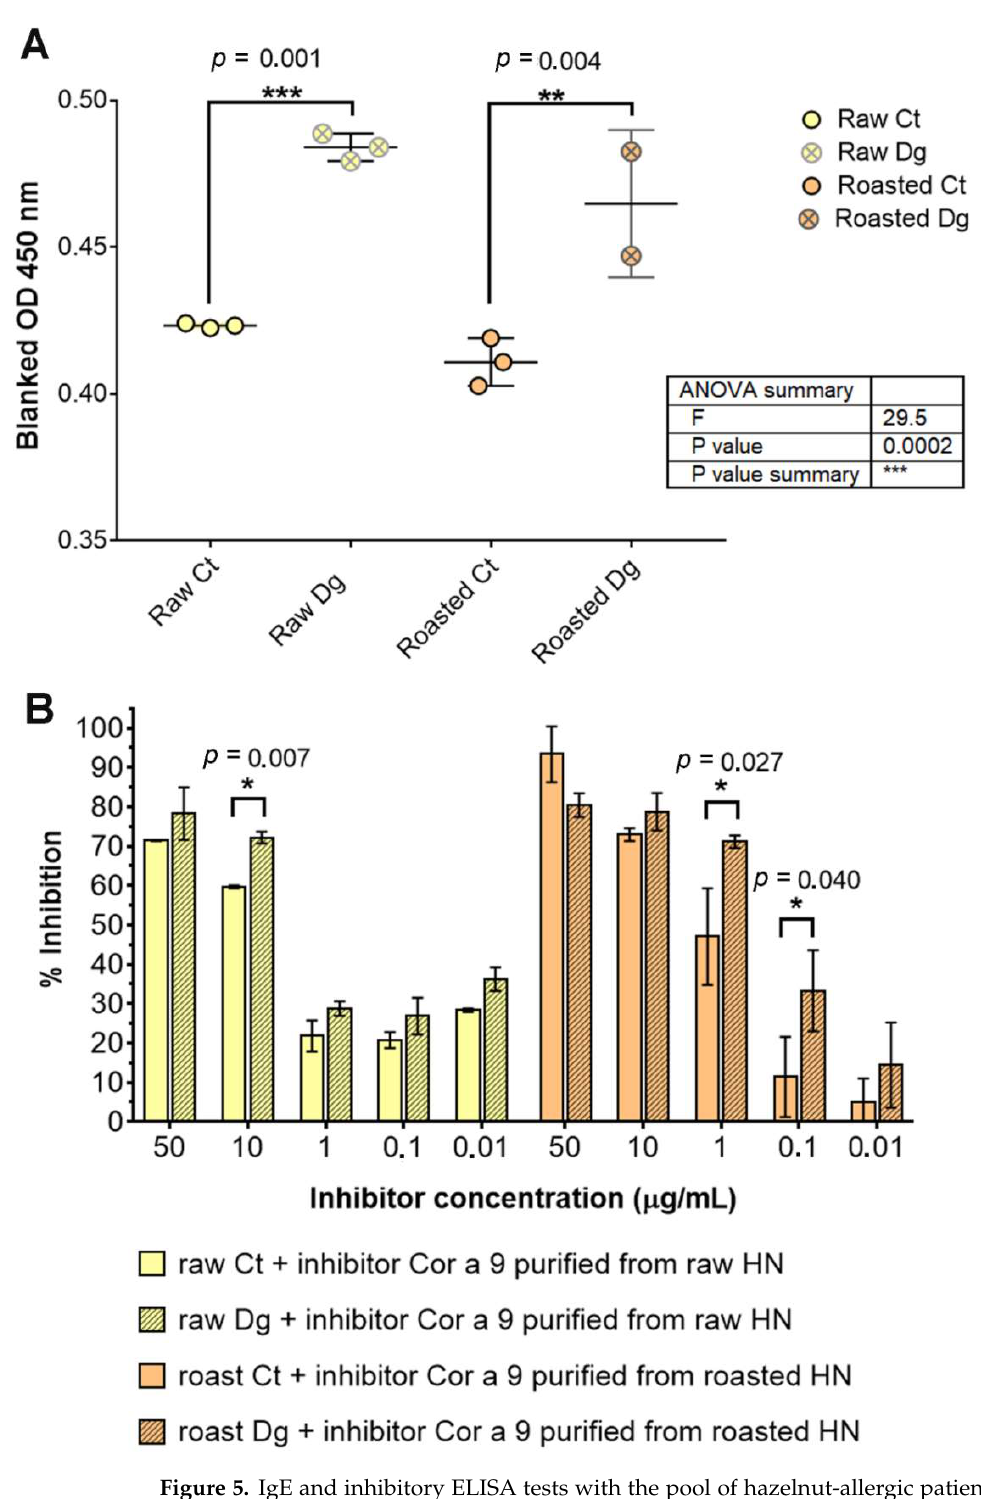
Figure 5. IgE and inhibitory ELISA tests with the pool of hazelnut-allergic patients’ sera: ( A ) IgE ELISA was performed in triplicate with the pool of sera of designated patients allergic to hazelnut, as specified in Table S1. One-way ANOVA test with Tukey’s multiple comparison post-test was applied to search for significant differences at an alpha value less than 0.05. ( B ) Inhibition of specific IgE binding by Cor a 9 obtained from raw and roasted hazelnuts. Unpaired two-tail t-testing was used with corrected multiple comparisons by the Holm–Sidak method with alpha set to 0.05. *significant difference at 0.005 < p < 0.05, **significant difference at 0.0005 < p < 0.005, ***significant difference at p < 0.0005, Ct—control sample, Dg—gastric phase, HN—hazelnut.